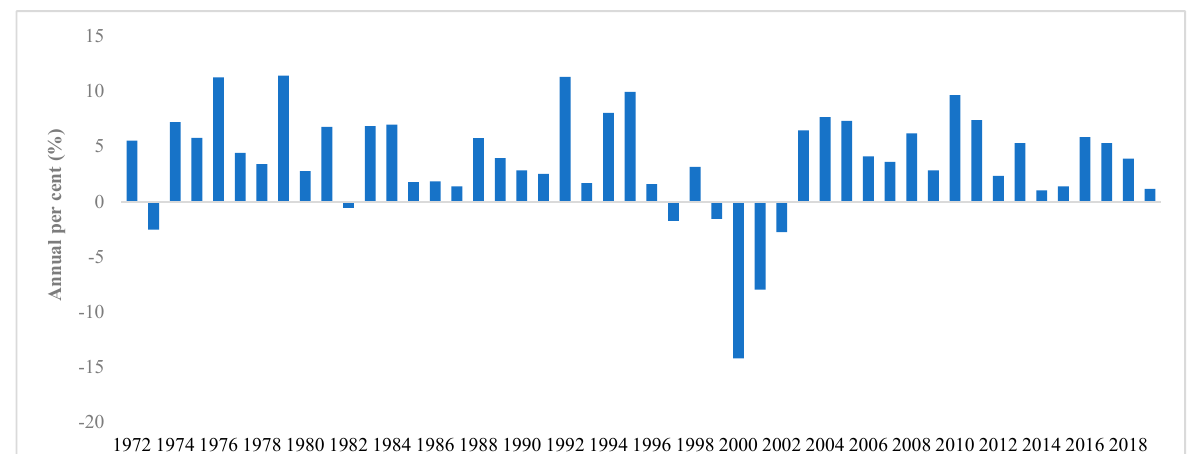
Figure 1. Solomon Islands economic growth rate, 1972–2019. Data from Central Bank of Solomon Islands (CBSI 2018a, 2018b, 2018c) and Solomon Islands National Statistics Office (SINSO